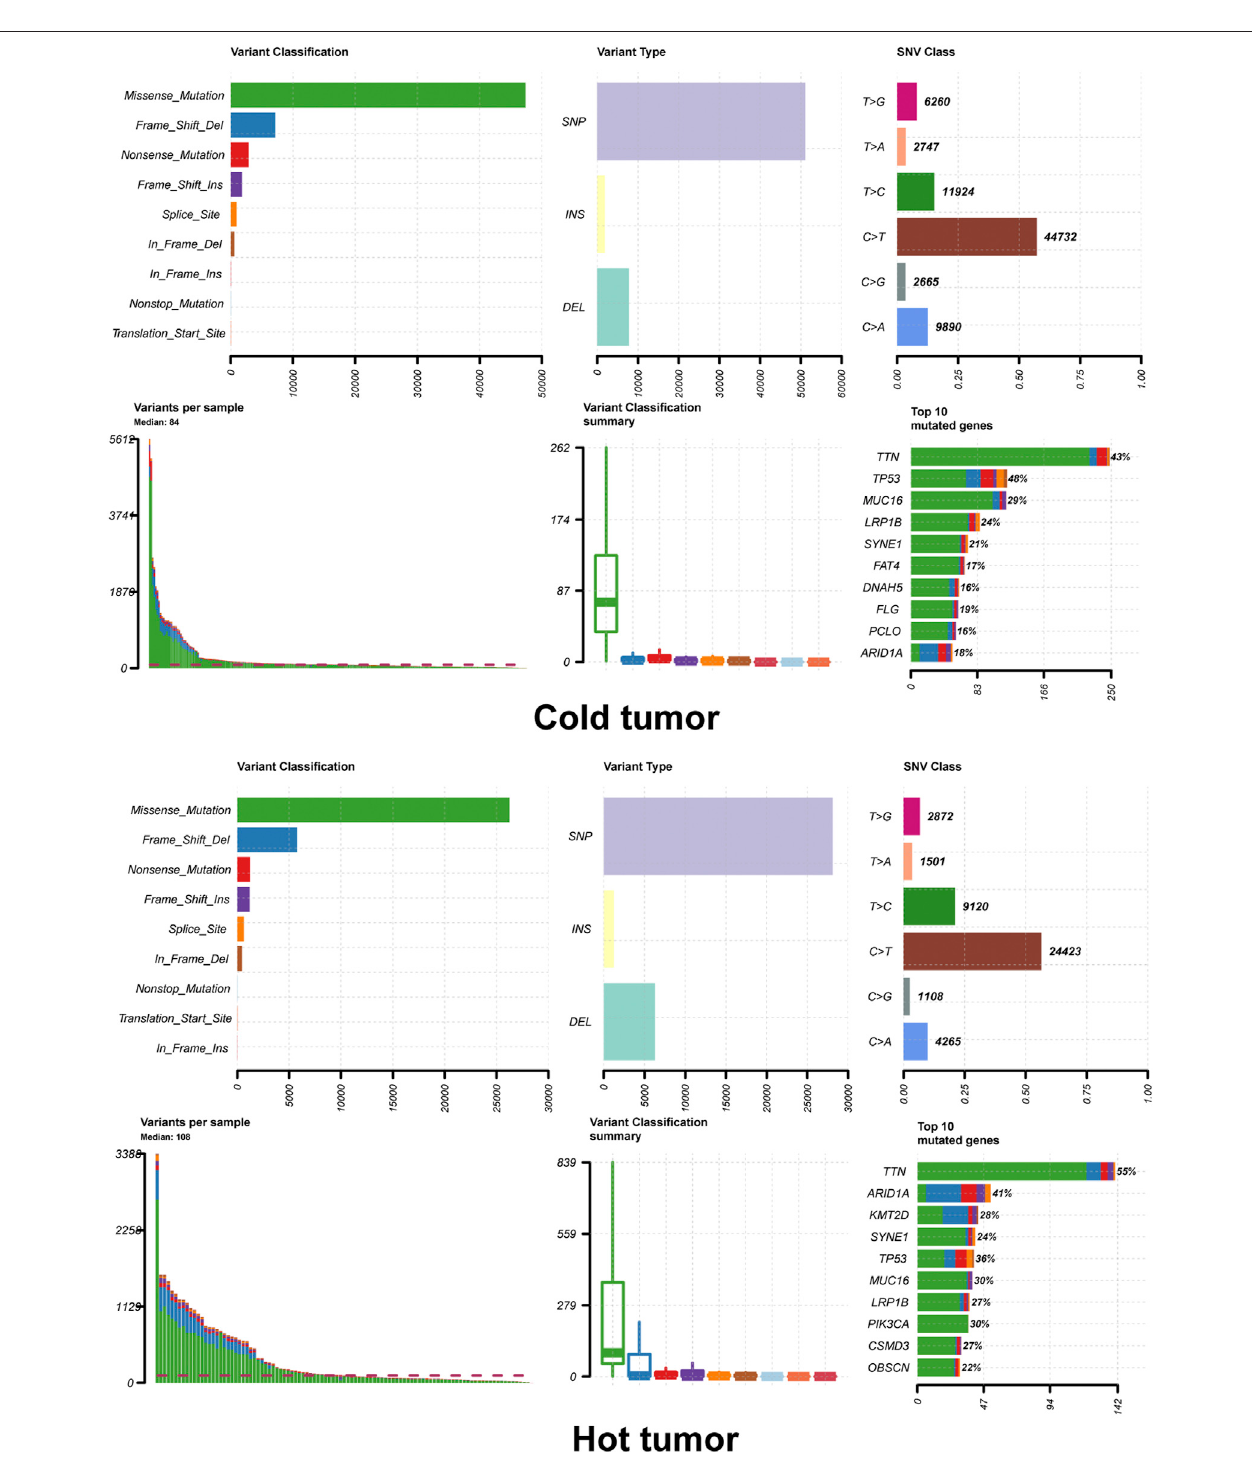
FIGURE 4 | Tumor mutation load of hot and cold tumors. The summary plot of tumor mutation load showed the variant classi fi cation, variant type and top 10 mutated genes.